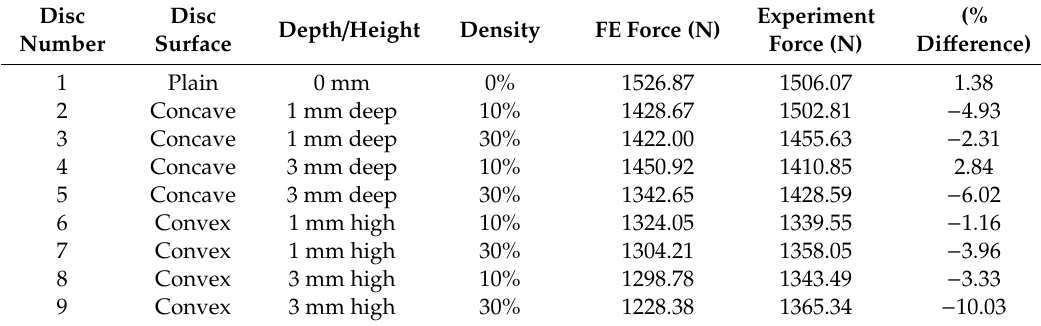
Table 3. Comparison of finite element model with experimental